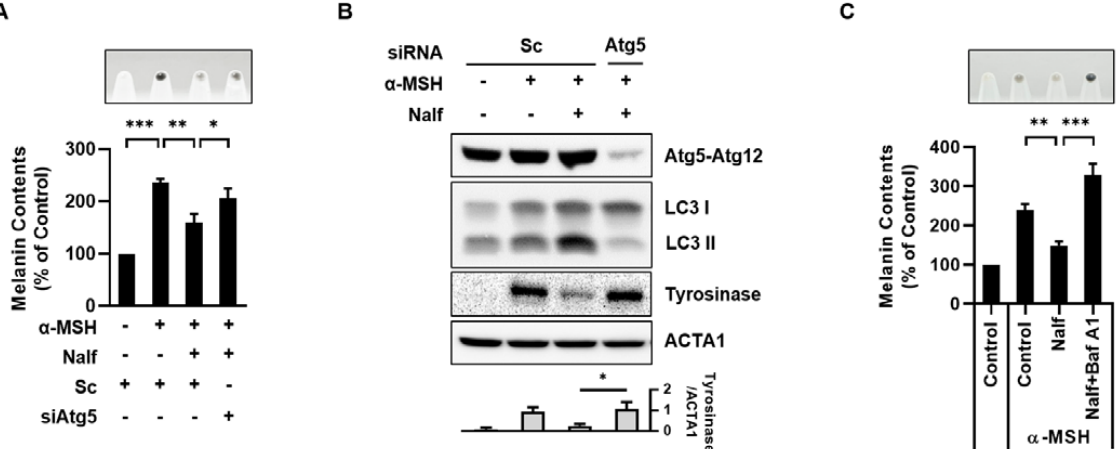
and visualized (upper panel), and the melanin content was measured. The protein levels were meas-